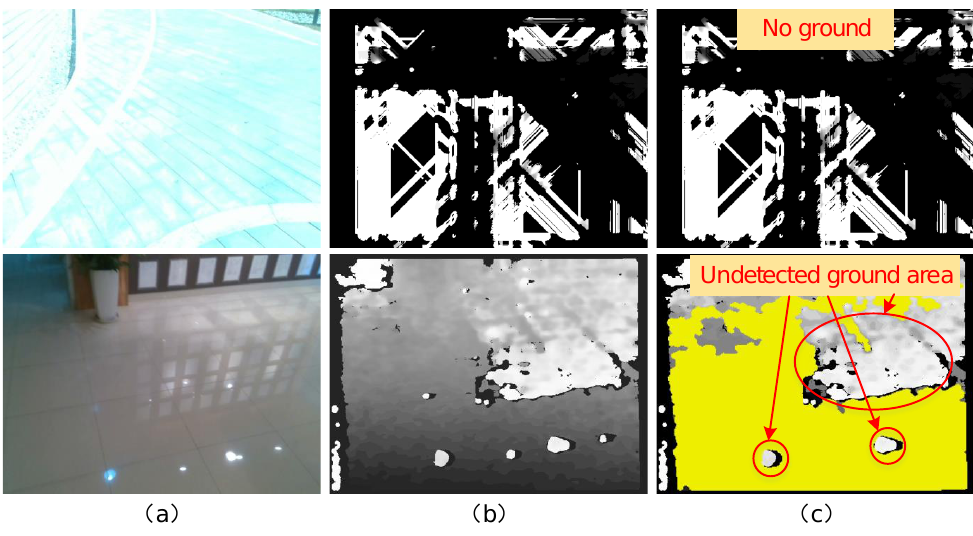
Figure 13. Errors of ground segmentation. ( a ) RGB image, ( b ) depth image, ( c ) the ground (the yellow region) detected by the proposed algorithm. The images of the first row show the outdoor scenario of overexposure where the proposed ground segmentation method failed to detect the ground. The images in the second row show the indoor scenario with ground reflection, where some areas are missed by the proposed method.